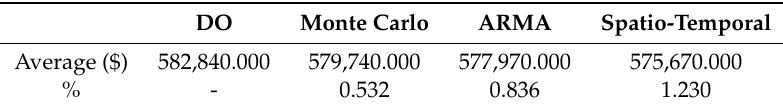
Table 11. Average